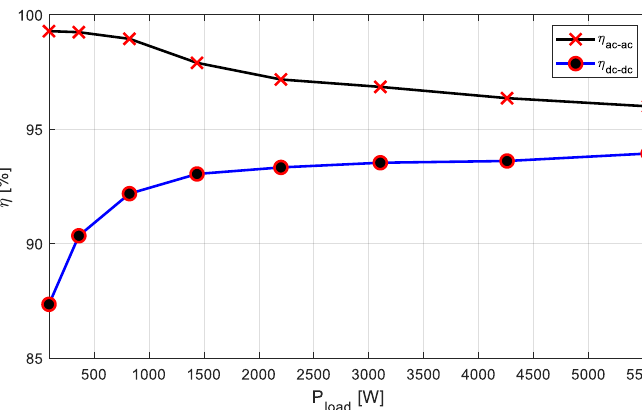
Figure 15. System e ffi ciency dependent on power delivered to Figure 15. System efficiency dependent on power delivered to load.